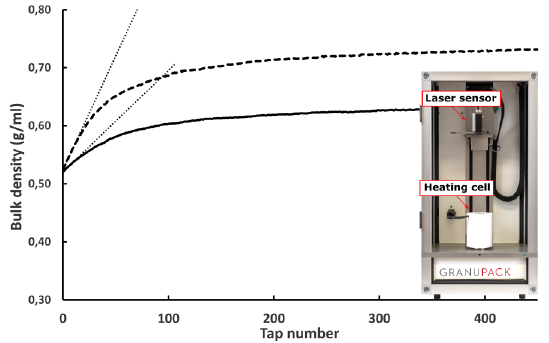
Figure 1. Packing dynamics curves obtained with the Granu- Pack instrument for the lactose powder at 20 ◦ C (dashed line) and 120 ◦ C (solid line). The slope of the initial stage of packing (dot- ted lines) highlight the slowdown of packing kinematics at higher temperature. Insert: picture of the GranuPack